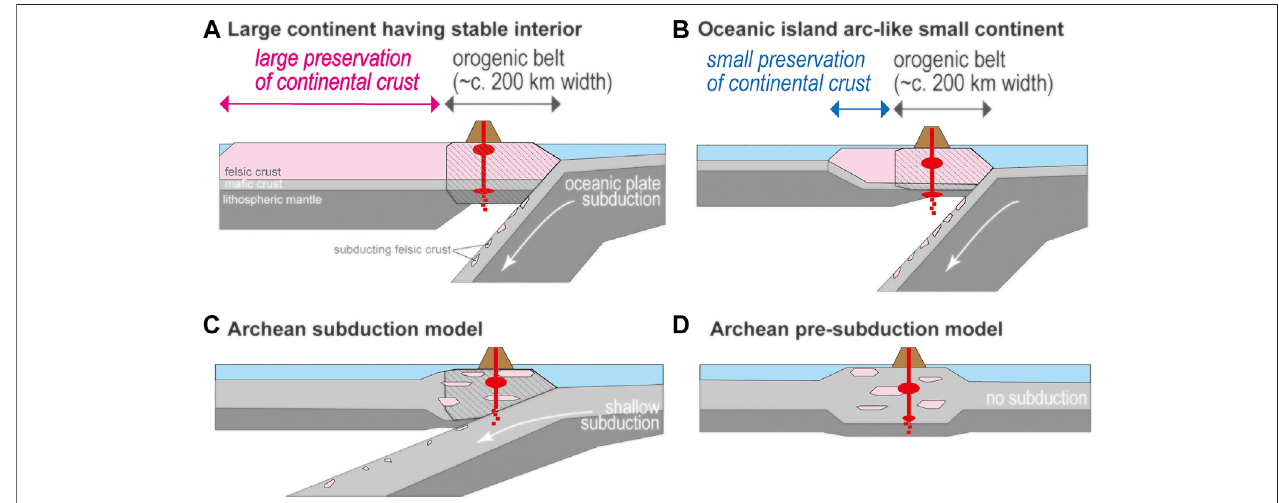
FIGURE 2 | Difference in the preservation of older continental crust from subduction orogen depending on the size of continental blocks (A) In a large continent, therearemanyareasofcontinentalinteriorfarfromthesubductionorogenandtheoldercrustcanbepreserved (B) Inasmallcontinentalblockliketheoceanicislandarc, mostofitiscoveredwithsubductionorogenicbeltand thereisonlylimited preservation ofrelativelyoldercrust (C) Archeansubductionmodelsimilar tomodernoceanic island arcs (D) Archean pre-subduction model.